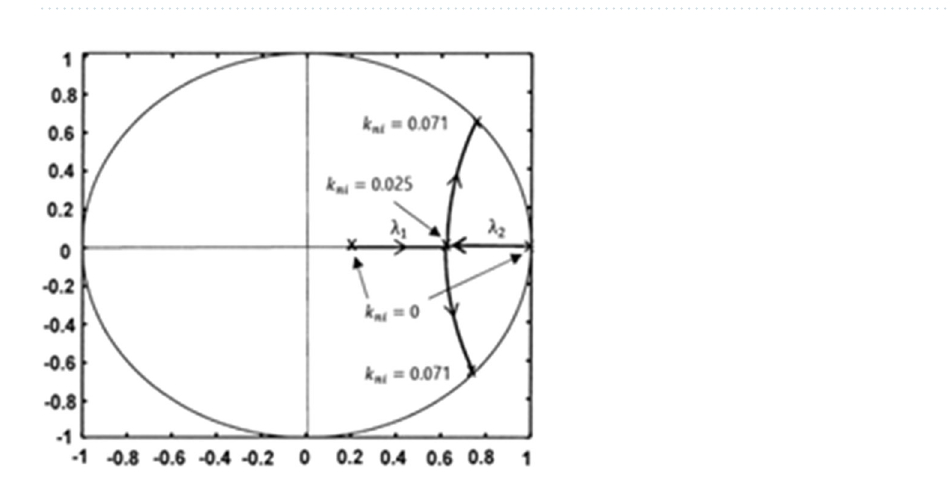
Figure 5. Root locus in the z-plane when varying S ro for k p =0, k ni =0.003, and D = 0.75.